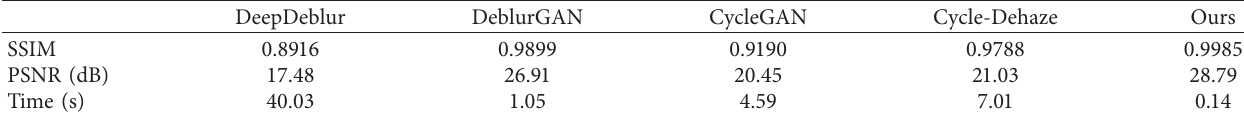
Figure 6: Deblurring results of the FLIR-A dataset. The columns from left to right are the original blurred image, results of Schuler et al. [39], Kupyn et al. [36], Zhu et al. [51], Engin et al. [64], and the results of the method proposed in this article. (a) Blurred image. (b) DeepDeblur. (c) DeblurGAN. (d) CycleGAN. (e) Cycle-Dehaze. (f) Ours. Table 3: Comparison of quantitative deblurring performance on FLIR-A